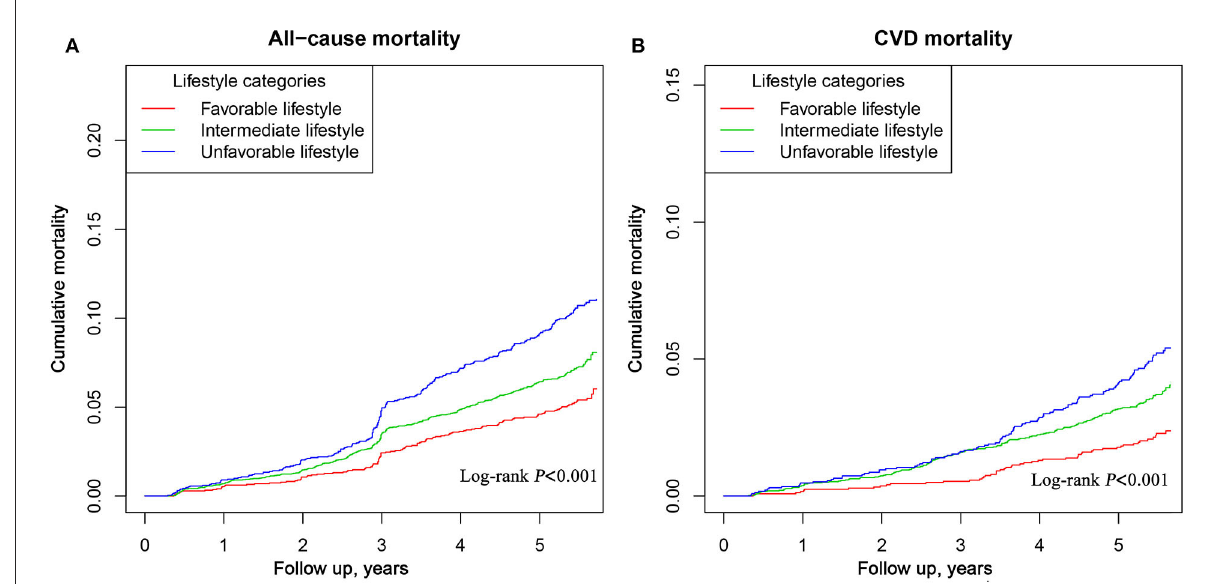
FIGURE2 Kaplan-Meier curves of all-cause (A) and CVD (B) mortality among participants in Jiangxi Province, China.